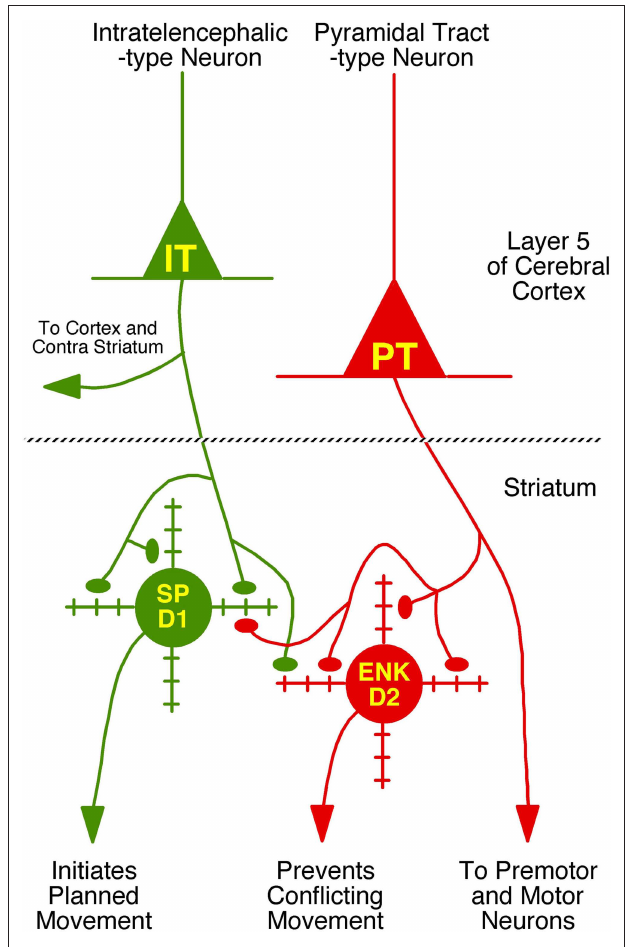
Figure 9 | Schematic illustration of the differential projections of iT-type and PT-type cortical neurons to the two main types of striatal projection neurons – the direct pathway type containing substance P (SP) and possessing D1-type receptors and the indirect pathway type containing enkephalin (eNK) and possessing D2-type dopamine receptors. The major functions and/or projection targets of each of the two main types of cortical pyramidal and striatal neurons is indicated. The degree of selectivity of IT-type input for direct pathway neurons, and PT-type input for indirect pathway neurons, as well as the extent of thalamic input to these two striatal neuron types is not yet known. Moreover, in our analysis, we have only considered axospinous input, and the axodendritic input to these neuron types from these three sources also needs to be